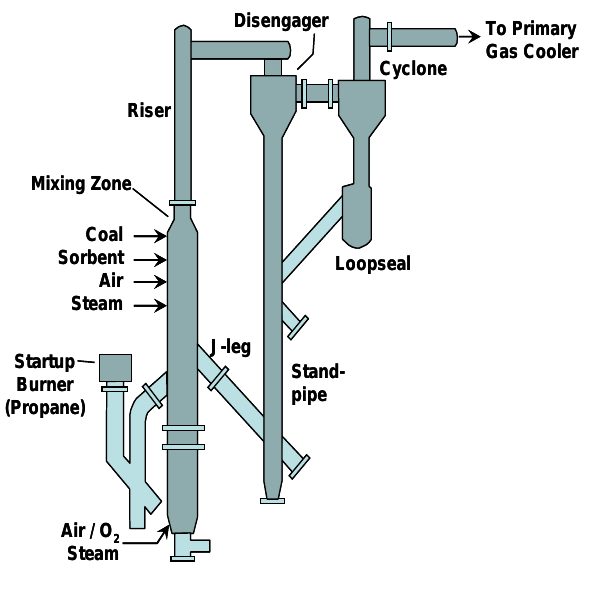
Figure 28. KBR Transport Gasifier.